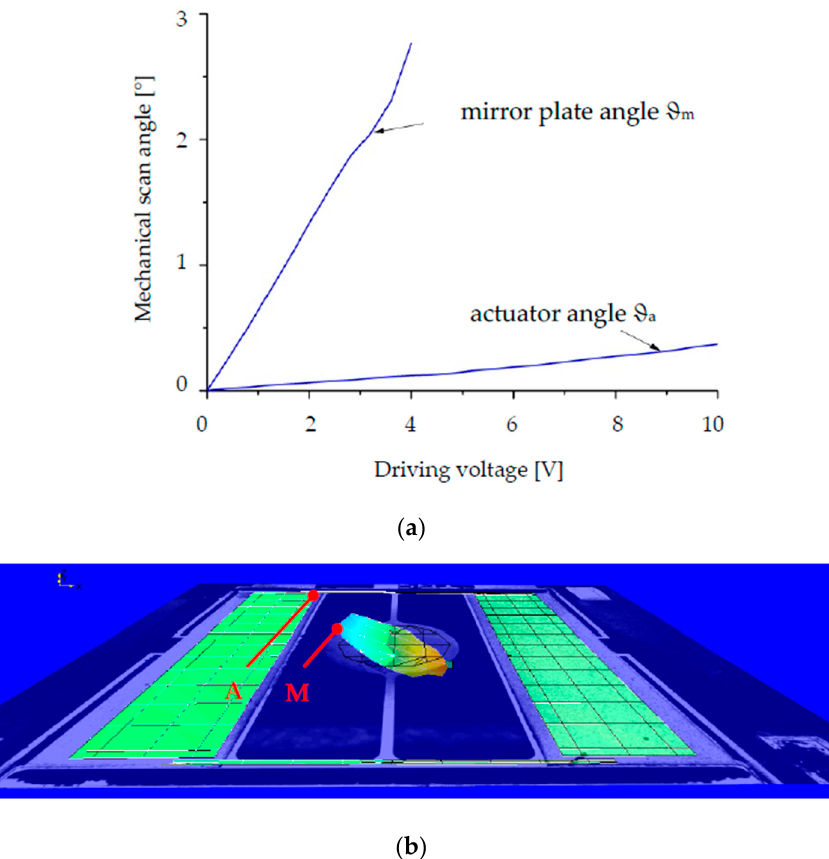
Figure 7. Laser-Doppler-Vibrometry (LDV) measurement results of micromirror with design S1 (measure points are A and M): ( a ) Mechanical scan angles of the mirror plate and the actuators; ( b ) Measurement recording of a deflected micromirror with scan angle of 2.5° measured at point M and the actuators with scan angle of about 0.08° measured at point A.